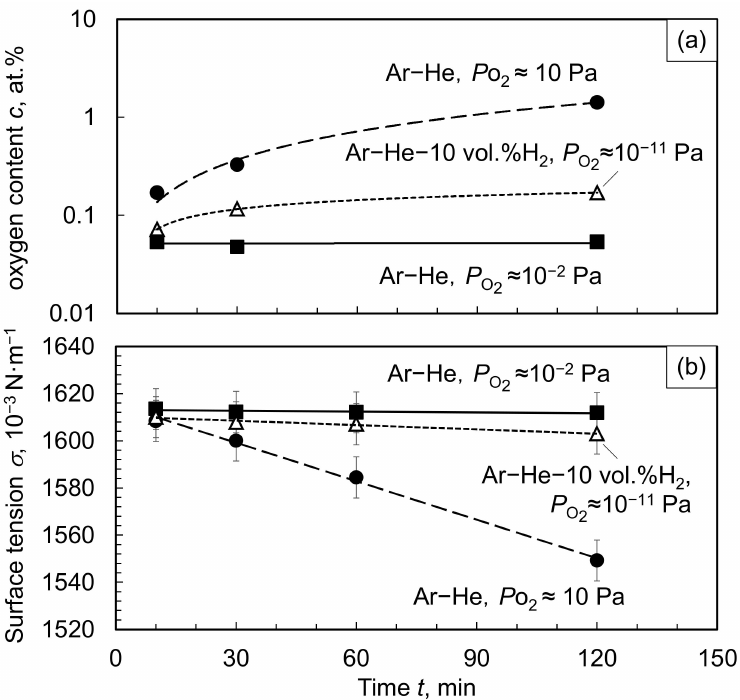
Figure 1. Time dependence of ( a ) oxygen content and ( b ) surface tension of liquid titanium maintained at 2000 K under different oxygen partial pressure, P O using